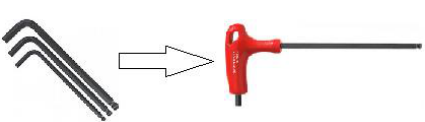
Figure 10 . Tool change: “Umbrako” for “Ergonomic T-handle”